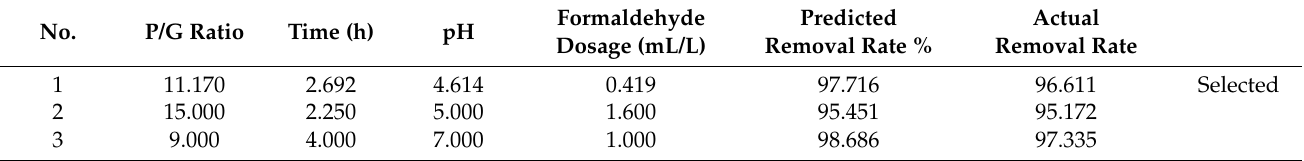
Table 5. Optimal conditions screening